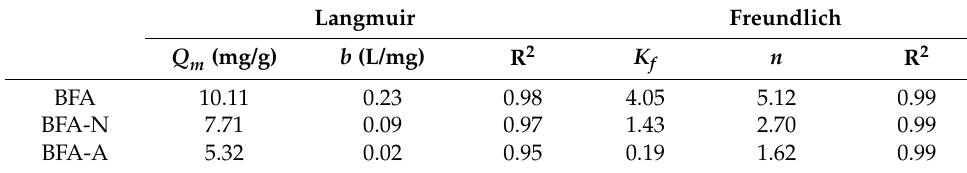
Figure 9. Isothermal adsorption fitting of Cd by BFA, BFA-N, and BFA-A, ( a ) Langmuir, ( b ) Freundlich. Table 3. Isothermal adsorption fitting parameters of Cd by BFA, BFA-N, and BFA-A. Langmuir